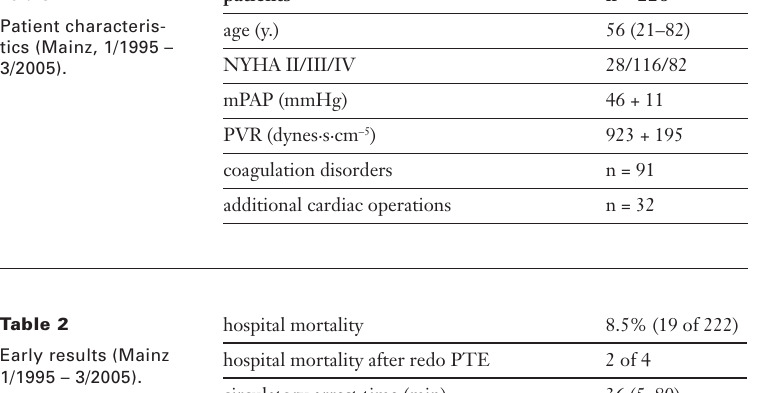
Early results (Mainz 1/1995 – 3/2005).